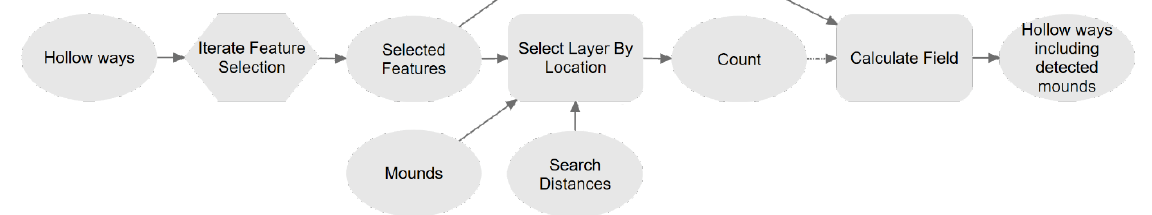
Figure 10. Proximity analysis of hollow ways and detected mounds. The dotted arrow between Count and Calculate Field is a precondition.